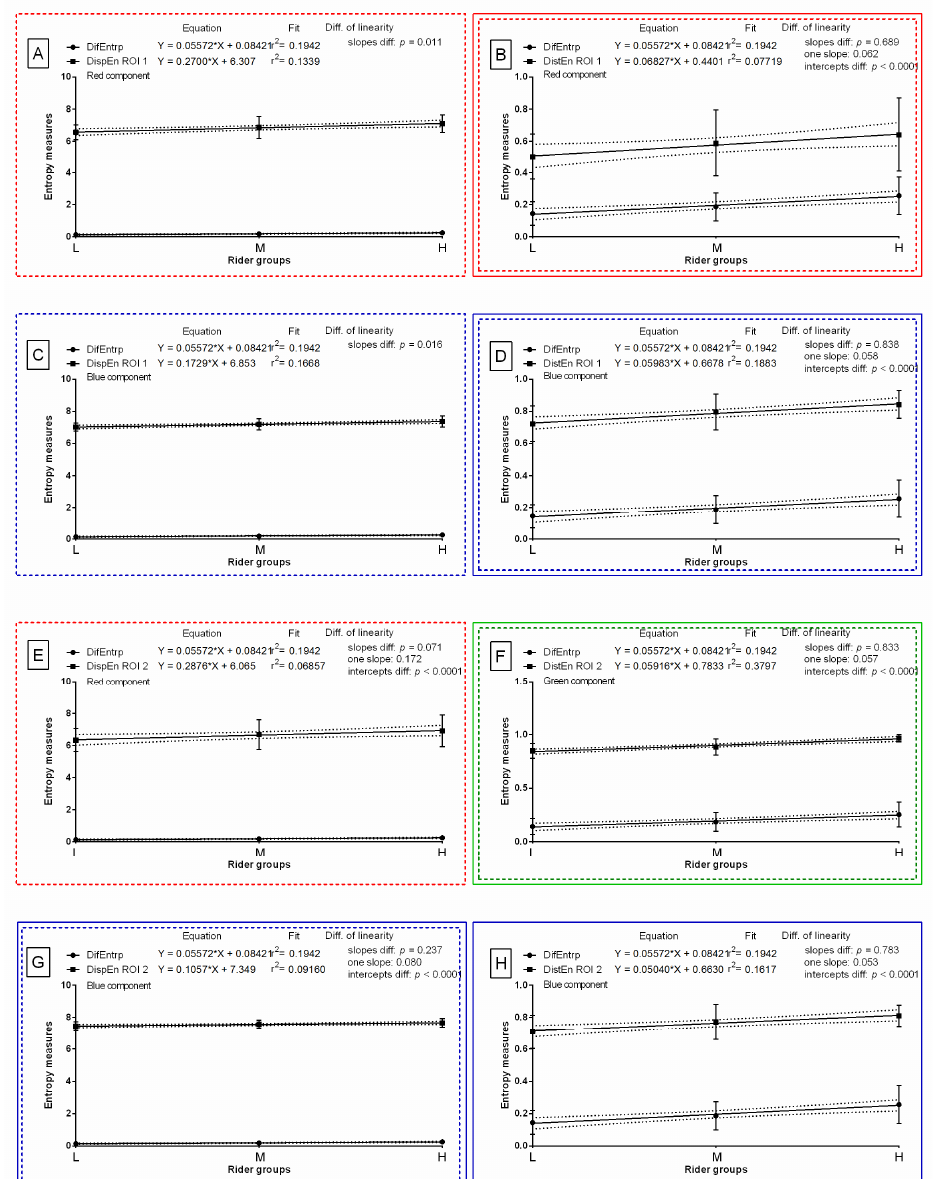
Figure 9. Comparison of studied entropy measures (DispEn—two-dimensional dispersion entropy, DistEn—two-dimensional distribution entropy) and selected gray-level run-length matrix feature (DifEntrp—differential entropy) for examined color components (red, ( A , B , E ); green, ( F ); blue, ( C , D , G , H )), which were found to be significantly different between light (L), moderate (M), and heavy (H) rider groups on the post-exercise imaging. Data were presented separately for the withers area (ROI 1) ( A – D ) and the thoracic spine area (ROI 2) ( E – H ). Similarity was tested using linear regressions. A p -value of less than 0.05 was considered significant. If the difference between slopes was not significant, a single slope measurement was calculated. Plots with the entropy measures and slopes that did not differ with DifEntrp were marked by colored (red, green, blue) solid frame. Plots with the entropy measures and slope values that were higher than DifEntrp were marked by colored (red, green, blue) dashed